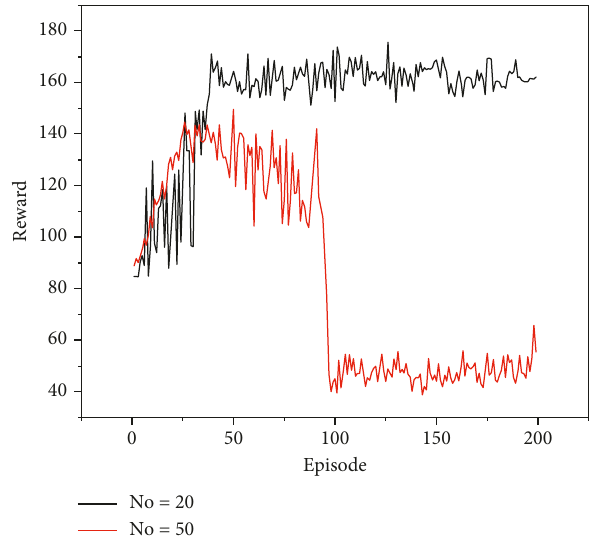
Figure 9: Training effects of critic with different numbers of neurons in hidden layers.